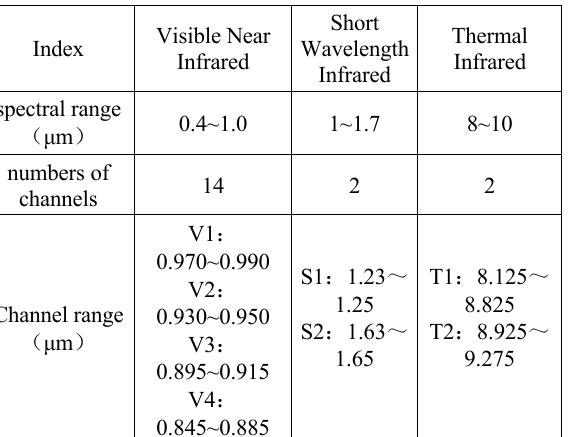
Interferometric Imaging Radar Altimeter working frequency 13.58 GHz work bandwidth 40 MHz certainty of backscatter